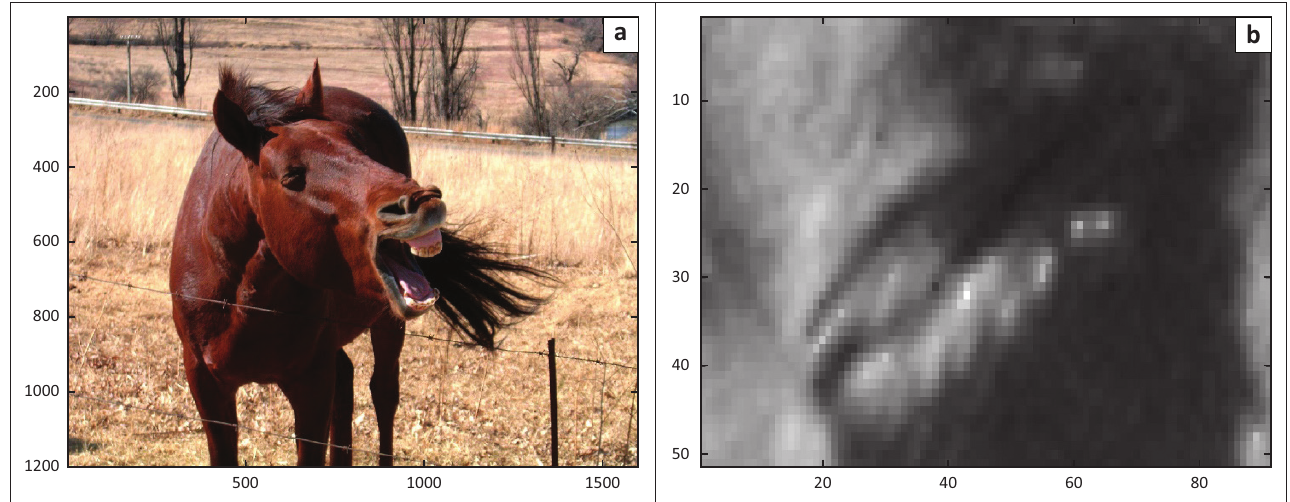
FIGURE 1: (a) Photograph of a horse. (b) Zooming in on the horse’s eye, viewed as a greyscale